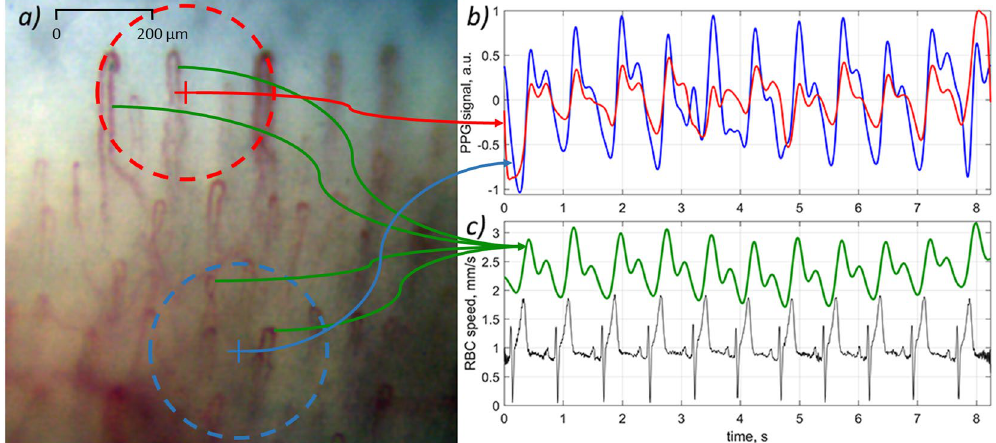
Figure 4. Synchronously recorded PPG waveforms, RBC-speed, and ECG. ( a ) One of the recorded microscopic images of capillaries. ( b ) Two PPG waveforms calculated in the areas marked by the red and blue circles in the image ( a ). ( c ) Mean RBC speed evaluated by video capillaroscopy system averaged over capillaries situated inside the circles (green curve) and ECG signal (black curve). Green arrows connect the graph of RBC